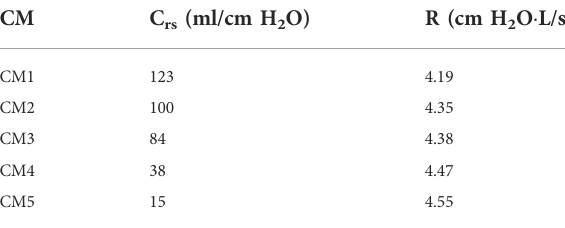
TABLE 2 Respiratory system compliance and resistance for each model from the adjustment of the equation of motion to the computed waveforms.